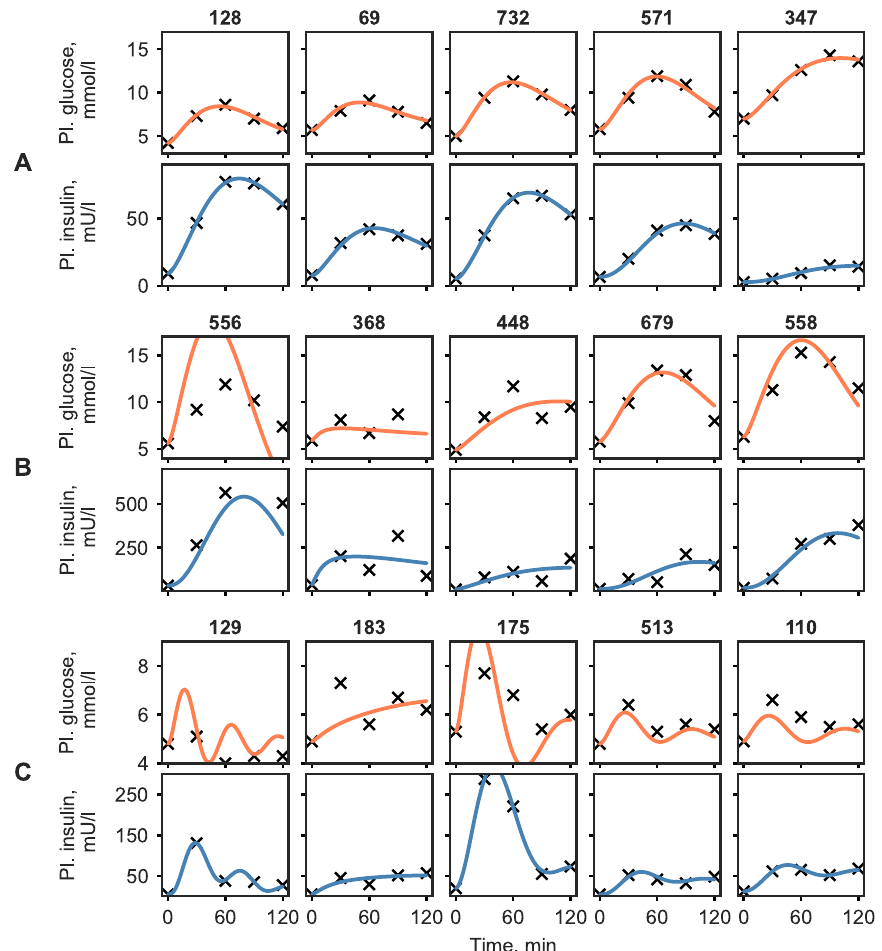
Fig 4. Time courses of plasma glucose and insulin concentrations for individuals with the lowest and highest simulation error (quantified by the SSR) in each ADA category, and other interesting model behaviour (A, B and C respectively). Black crosses and orange/blue lines correspond to measurement and model simulation of glucose/ insulin, respectively.